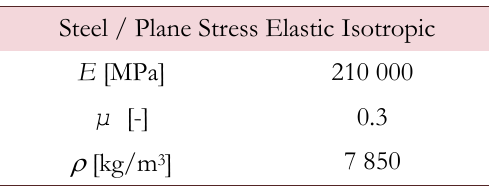
Table 2: Input parameters of the Plane Stress Elastic Isotropic numerical model for steel bars.